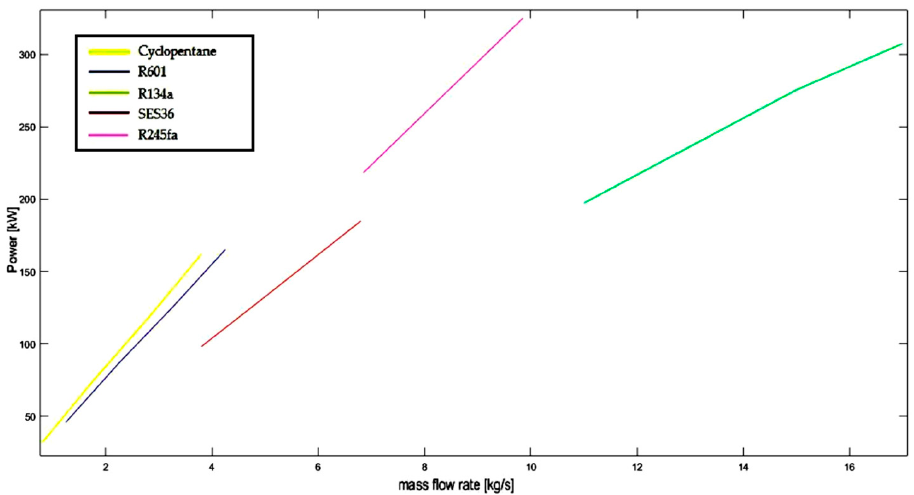
ff erent power output for di ff erent working Figure 17. Different power output for different working fluids. Figure 17. Di